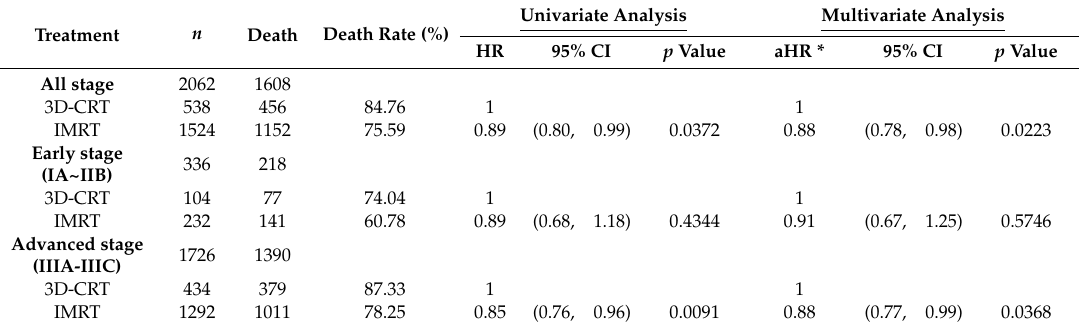
Table 3. American Joint Committee on Cancer (AJCC)-stage-stratified Cox proportional hazards model for mortality risk associated with treatment modalities in patients with TESCC receiving concurrent chemoradiotherapy